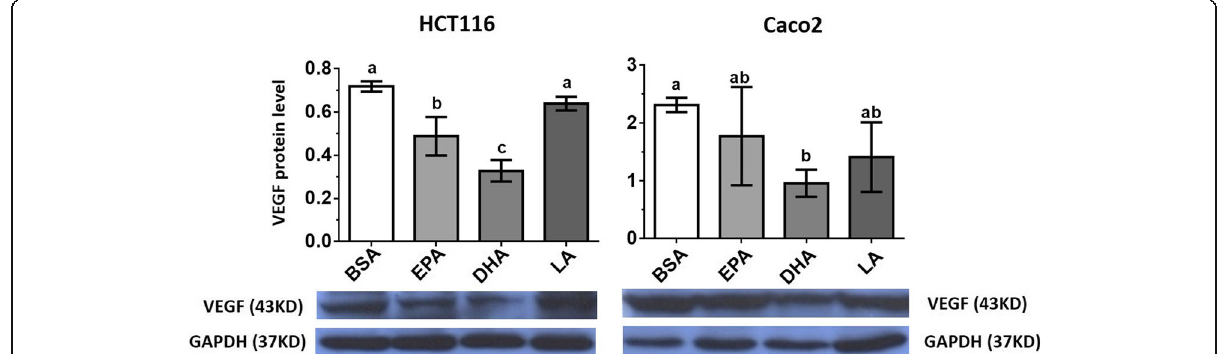
Fig. 4 The effect of pure PUFAs on VEGF protein expression level was determined by western blotting analysis in HCT116 and Caco2 cell lines. Mean values ± SD of the three experiments are given. Bars marked with letters are significantly different as verified by Tukey ’ s honestly significant difference multiple comparison test. EPA, eicosapentaenoic acid; LA, linoleic acid; DHA, docosahexaenoic acid; BSA, bovine serum